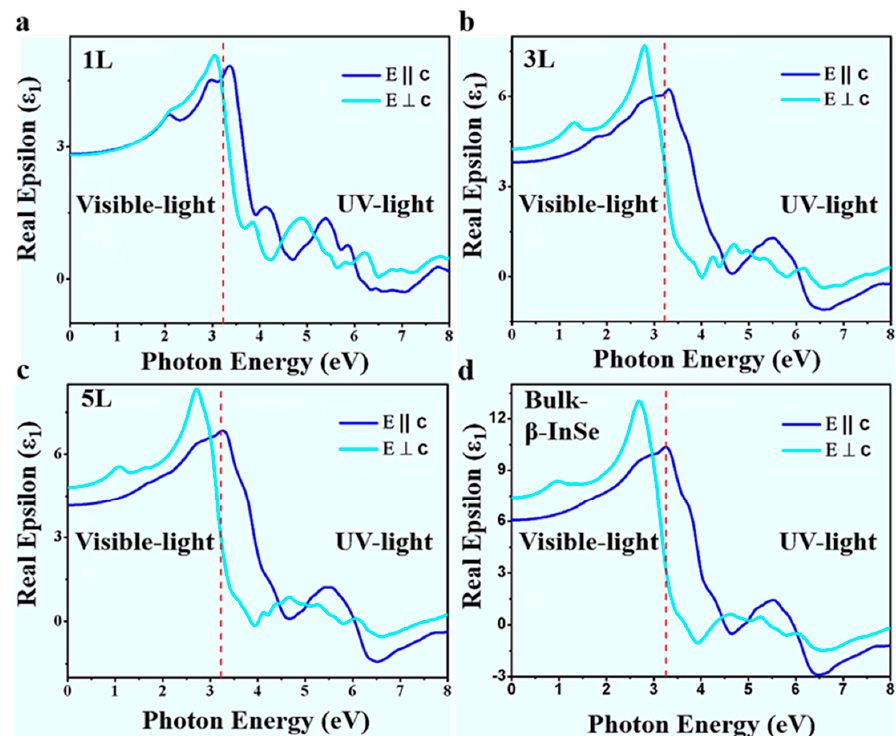
Figure 5. ( a – d ) Calculated real part of the dielectric function a long x and z directions for β -InSe monolayer (1 L), few-layer (3 L and 5 L) and bulk β -InSe.